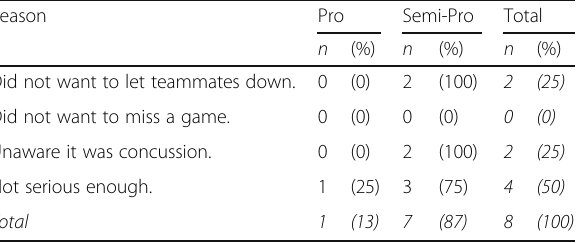
Table 3 Reason for not reporting concussive symptoms Reason Pro Semi-Pro Total n (%) n (%) n (%)